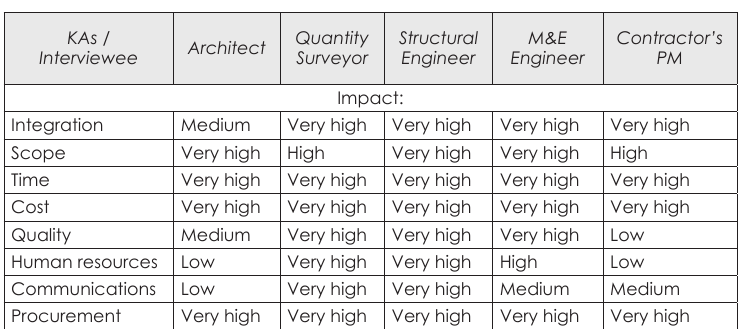
Risks’ impact perceptions on the other PMI knowledge areas in Case